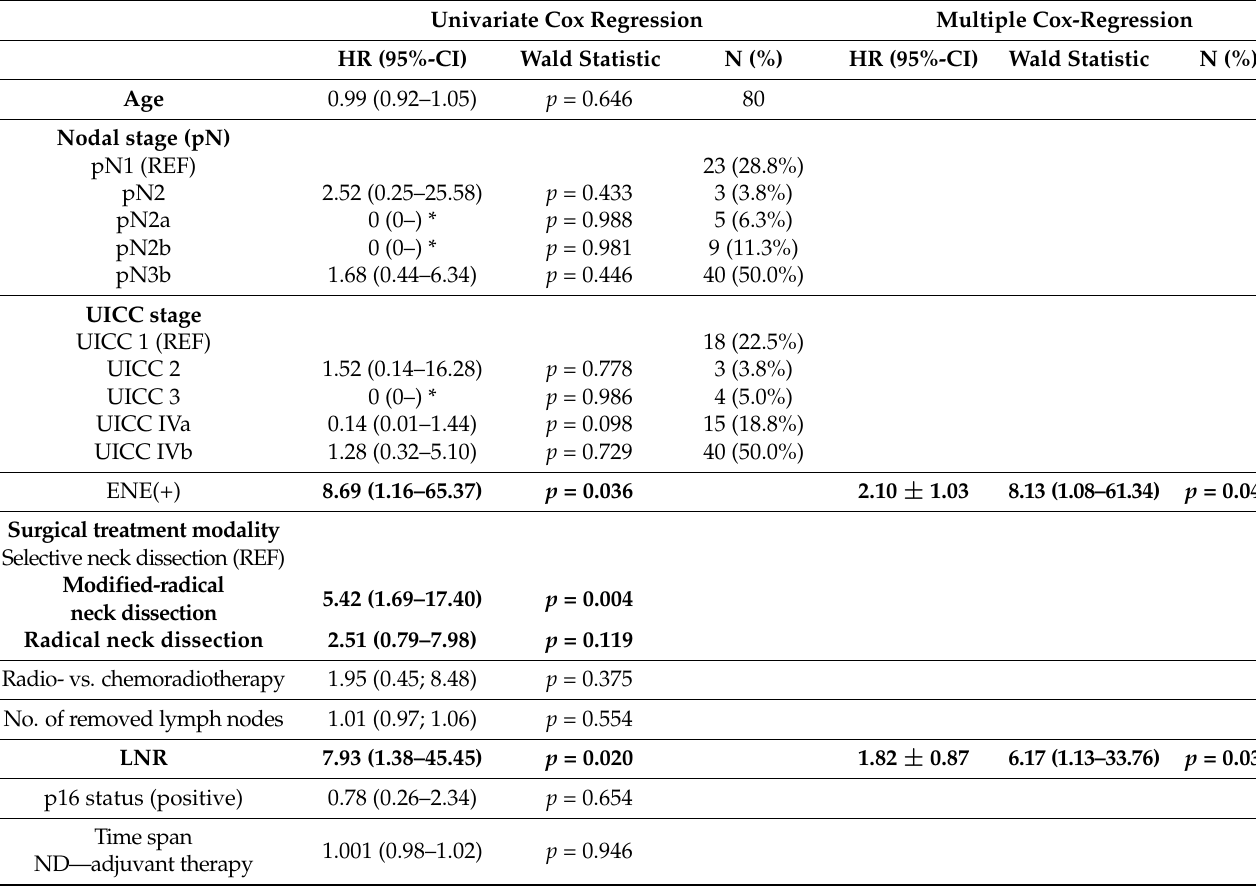
Table 6 shows the univariate and multiple Cox regression for PFS. Table 6. Univariate and multiple Cox regression for